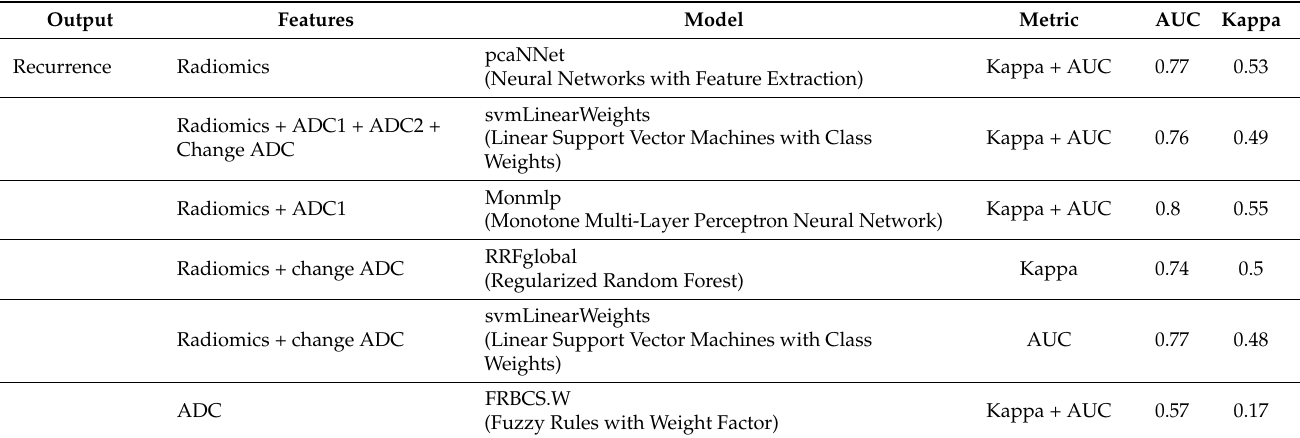
Table 2. Tabulated content of recurrence with relevant classifier algorithm and corresponding AUC with Kappa values.